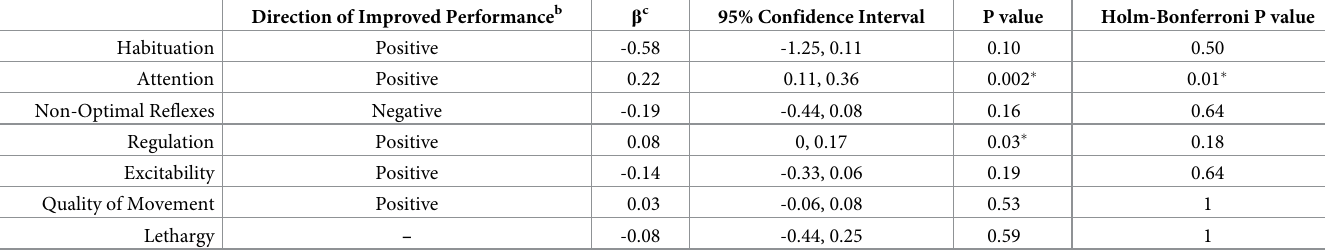
Table 5. Adjusted multivariable linear regression of the association between ∑DEHP and NNNS summary scales a